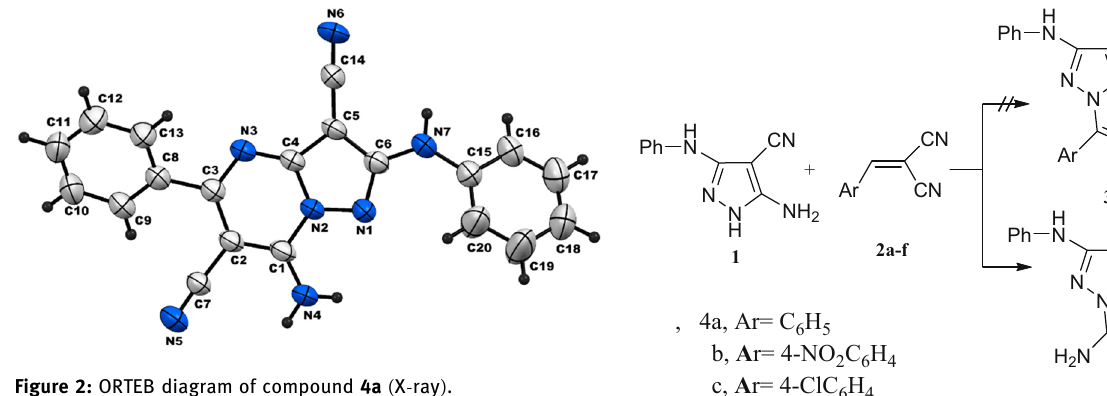
Figure 2: ORTEB diagram of compound 4a ( X - ray ) .